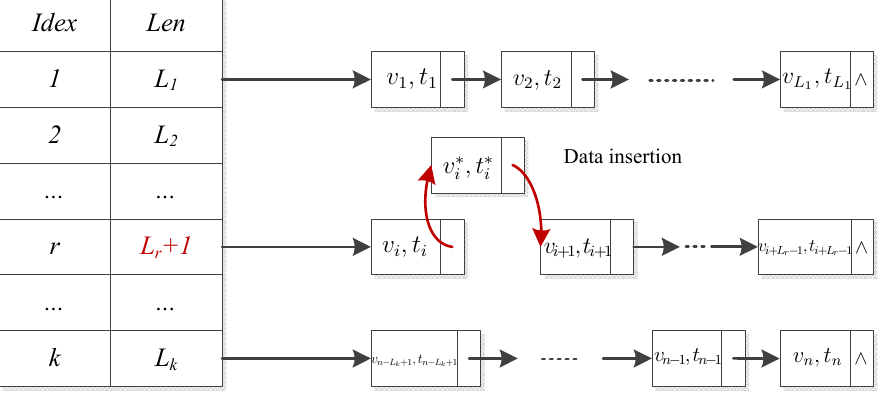
Figure 5. Data block insertion operation.